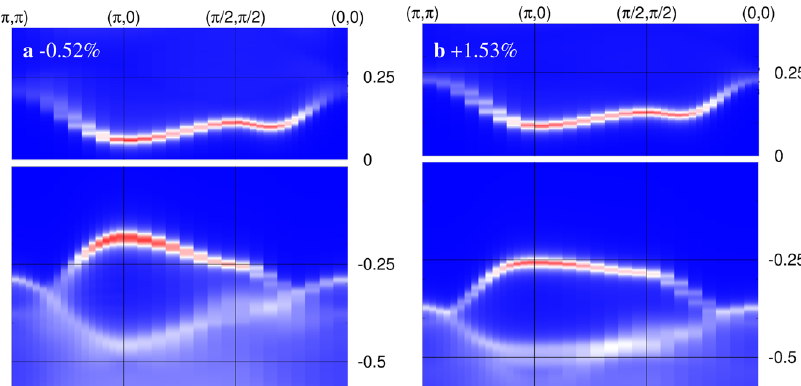
Fig. 6 Dependency of the spectral function of Sr 2 IrO 4 on the strain. Spectral function calculated for various strain values: a LSAT, − 0.52% (compressive strain), b GSO, + 1.53% (tensile strain) corresponding to ARPES (negative energies) and inversed photoemission spectra (positive energy). The horizontal axis is the 2D crystal momentum. The vertical axis is the energy (eV), where zero energy represents the Fermi level.